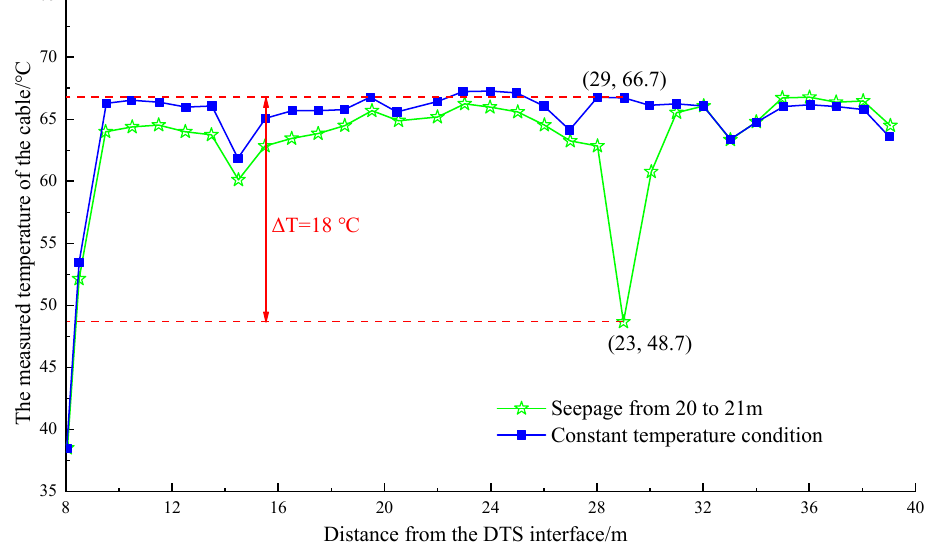
Figure 14. Temperature drop curve at the position of 20~21 m in the pipeline. Figure 13 shows that after continuous watering at a distance of 22–23 m from the DTS joint (the first 8 m of the optical cable was not laid on the heating pipe), the maximum temperature dropped approximately 11.6 ◦ C within the range of 22–24 m. Moreover, the minimum temperature was 55.6 ◦ C, which occurred at 23 m. Figure 14 shows that after stopping the watering and waiting for the temperature to stabilize, the maximum temperature dropped by approximately 18 ◦ C within 28–30 m after continuous watering at a distance of 28–29 m from the DTS joint. The minimum temperature was 48.7 ◦ C, appearing at the position of 29 m. For different parts of the pipe in multiple sections, the temperature curve of the pipe is shown in Figures 15 and